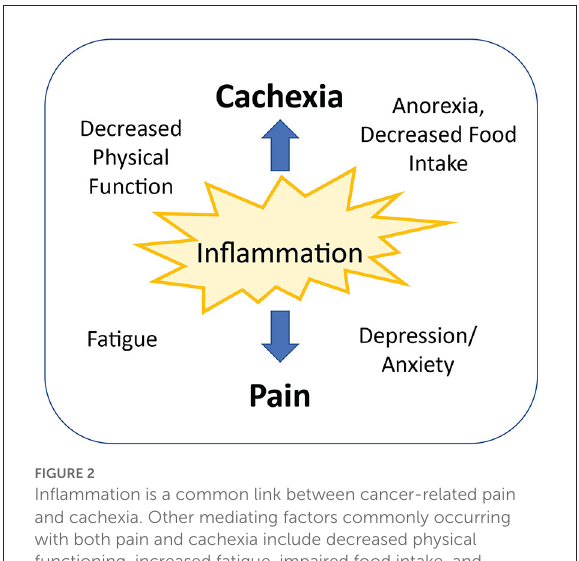
FIGURE2 Inflammation is a common link between cancer-related pain and cachexia. Other mediating factors commonly occurring with both pain and cachexia include decreased physical functioning, increased fatigue, impaired food intake, and decreased mental